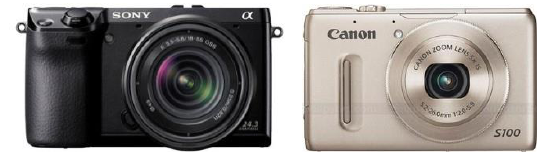
Figure 4. Camera (Sony NEX7/left, Canon